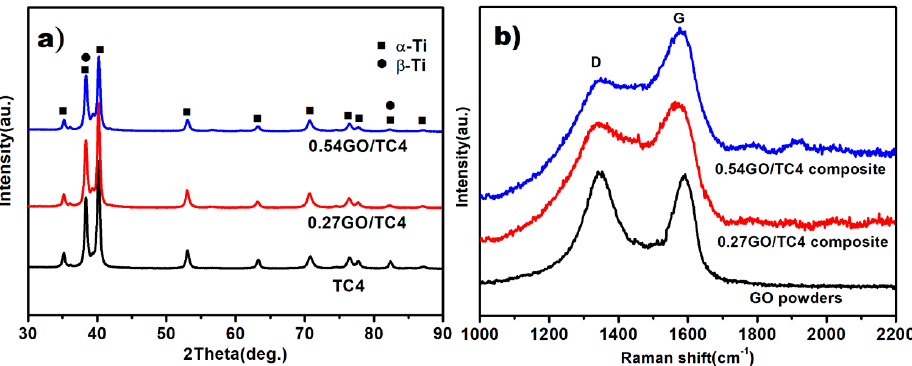
Figure 4. ( a ) XRD results of sintered samples, and ( b ) Raman spectra of as-received GO powders and sintered TC4 and sintered TC4 composites.